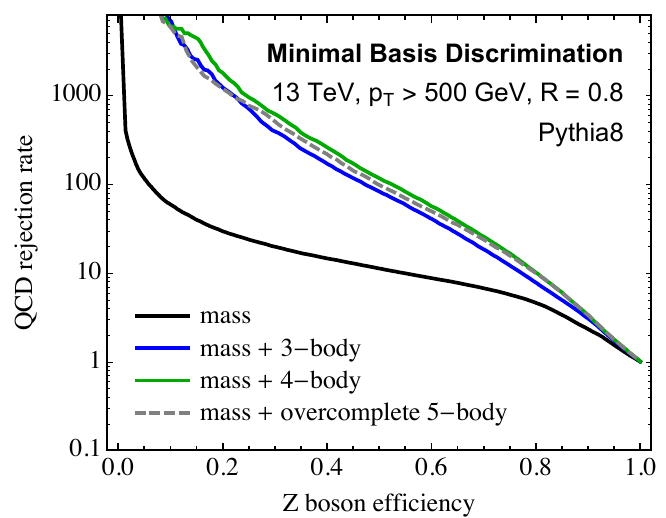
Figure 6. Signal e(cid:14)ciency versus background rejection rate for jet mass plus the overcomplete basis of observables that are sensitive to 5-body phase space described in the text, as determined by the neural network. For comparison, we also include the signal e(cid:14)ciency versus background rejection rate for jet mass, jet mass plus minimal 3-body phase space observables, and jet mass plus the minimal 4-body phase space